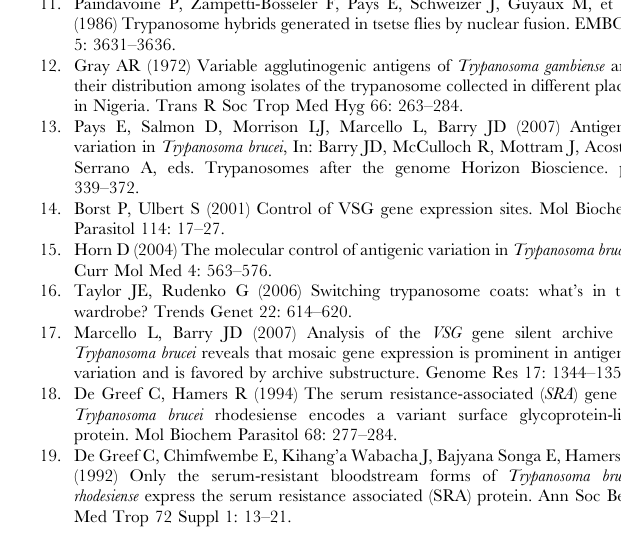
Figure S1 Disruption to co-linearity on chromosome 9 con- cerning an internal VSG ‘island’. Found at: doi:10.1371/journal.pntd.0000658.s001 (0.40 MB TIF) Figure S2 Tandem duplication on chromosome 3 in T. b. brucei . Found at: doi:10.1371/journal.pntd.0000658.s002 (0.46 MB TIF) Figure S3 Tandem duplication on chromosome 6 in T. b. brucei . Found at: doi:10.1371/journal.pntd.0000658.s003 (1.22 MB